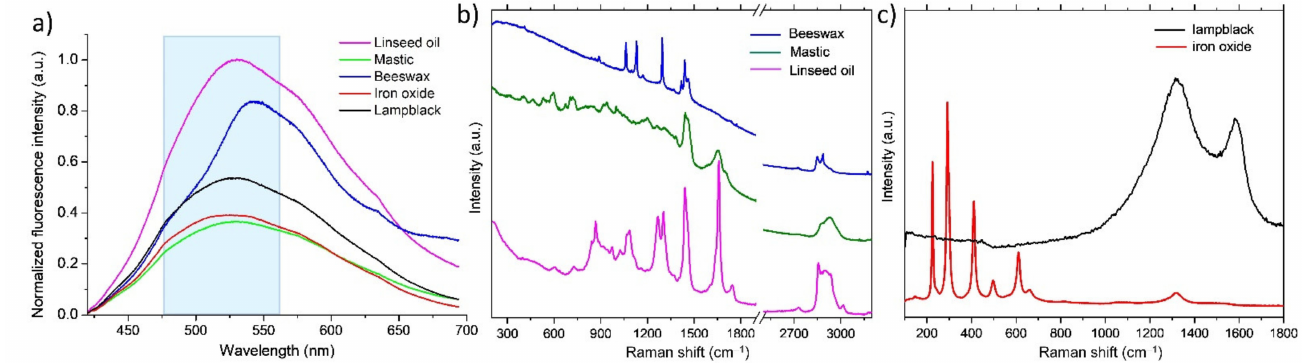
Figure 1. Fluorescence emission ( a ) and Raman ( b , c ) spectra of the analyzed materials. Regarding the pigments, the Raman spectrum of the red pigment clearly shows the characteristic peaks of iron oxide at 225 cm − 1 , 293 cm − 1 , 410 cm − 1 , 497 cm − 1 , 611 cm − 1 , 1317 cm − 1 , assigned to ν s (Fe-O), δ s (Fe-O), and ν as (Fe-OH) [42,43]. An additional peak at 659 cm − 1 may belong to iron impurity in the form of magnetite, or to a disorder band in the crystalline structure of hematite, caused by exposure to a high temperature during burning [44,45]. On the other hand, the lampblack pigment is characterized by the two broad bands of amorphous carbon—at 1315 cm − 1 and 1591 cm − 1 —assigned to the D- and G-bands of CC, respectively